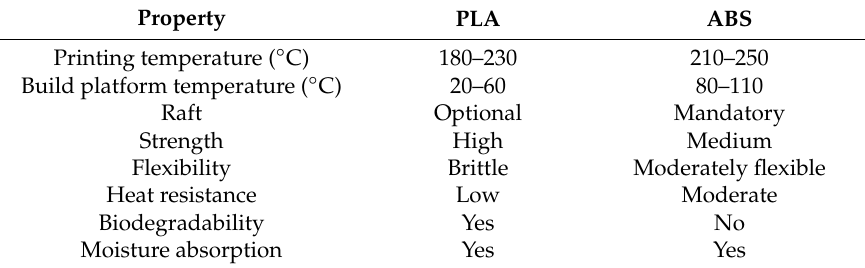
Table 1. Properties of polylactic acid (PLA) and acrylonitrile butadiene styrene (ABS)